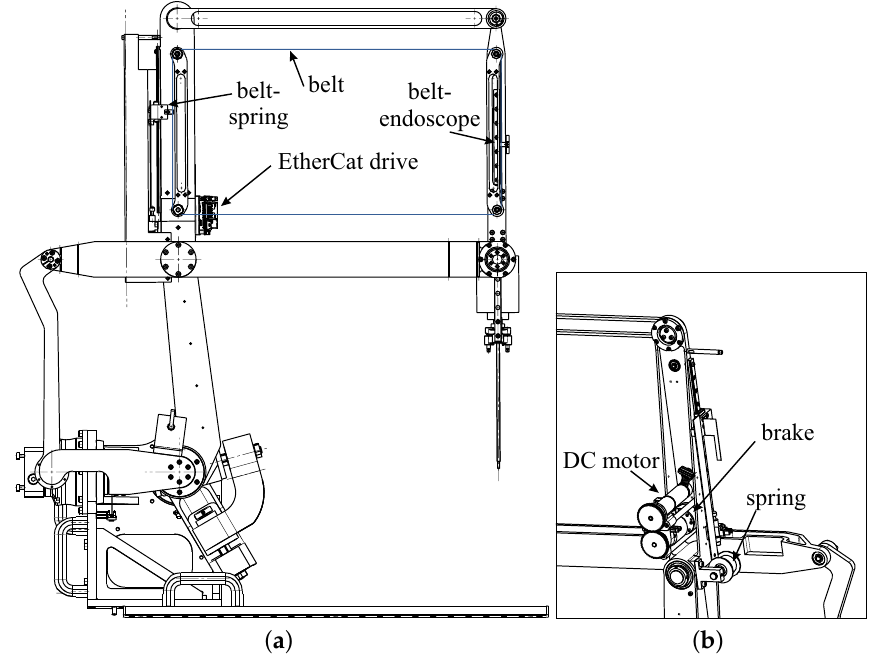
Figure 5. CAD modeling of the prototype ( a ) connection among DC motor, belt, brake, spring, and endoscope and ( b ) a zoom in on the arrangement of the spring, motor and brake.